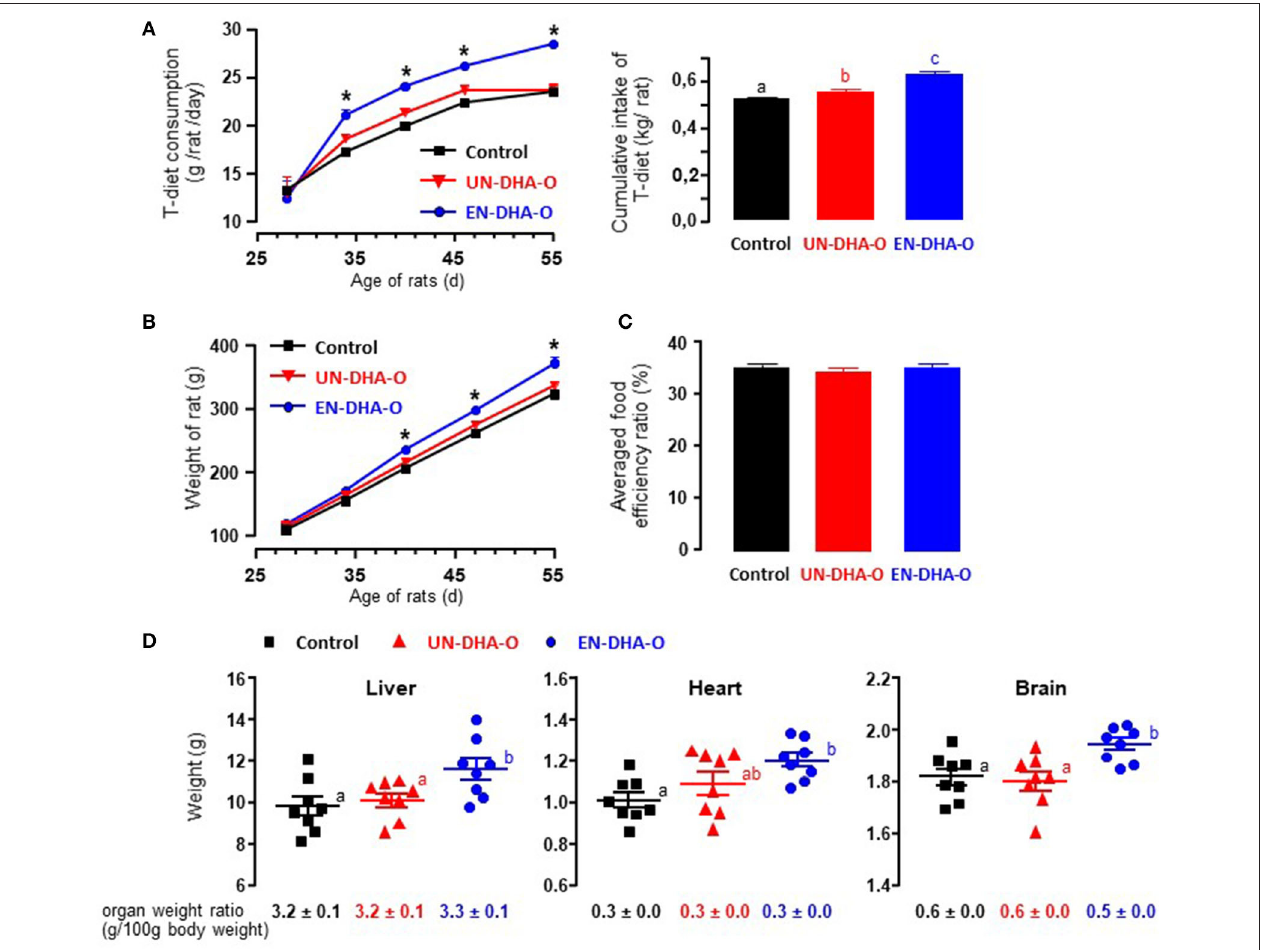
FIGURE 2 | The food intake (A), the growth (B) , the food efficiency ratio (C) , and the tissue weights (D) of rats. Food consumption of T-diet and animal growth were followed during the four-week experiment. Food efficiency ratio averaged over the four-week experiment was calculated with the daily consumption of T-diet and omelets over the weight gain of growing animals. The effect of diets was determined as well on the tissue weight prior to lipid analysis. a, b, c and ab indicate significant differences between the three groups when p < 0.05; ab means no difference with a and no difference with b. * indicates significant differences between EN-DHA-O and both Control and UN-DHA-O when p <